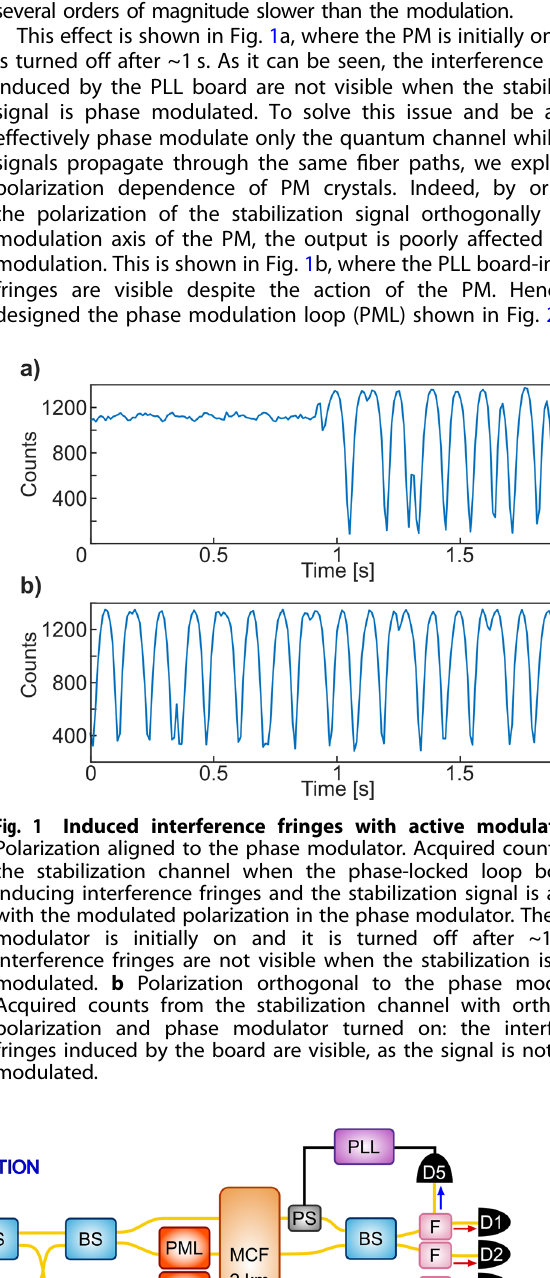
Fig. 2 Experimental setup. a Phase modulation loop. Red arrow: quantum channel; blue arrow: stabilization channel; yellow fi ber: single- mode fi ber; blue fi ber: polarization-maintaining fi ber; PBS polarizing beam splitter; PM phase modulator; PC polarization controller. b Setup scheme. Red arrow: quantum channel; blue arrow: stabilization channel; VOA variable optical attenuator; IM intensity modulator; BS beam splitter; SWITCH optical switch; PML phase modulation loop, see ( a ); MCF multicore fi ber; PS phase shifter; PLL phase-locked loop board; F wavelength division multiplexing fi lters; D1, D2, D3, and D4: superconducting nanowire single-photon detectors; D5 and D6: InGaAs single- photon